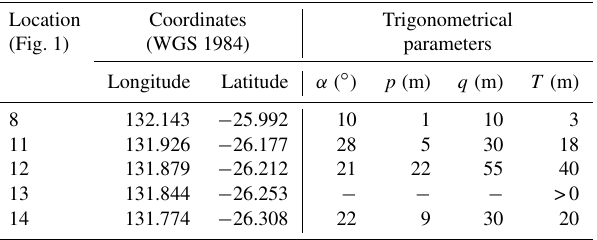
Table 3. Angle of dip ( α ), elevation difference ( p ), apparent thick- ness ( q ) and true thickness ( T ) of the Woodroffe Thrust mylonites derived from the hanging